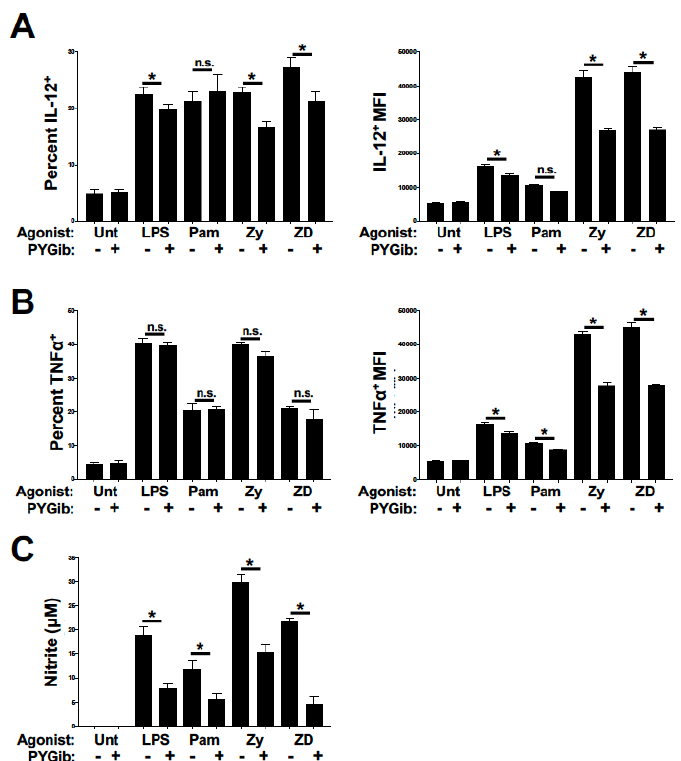
Figure 3. Glycogen phosphorylase inhibition causes deficits in inflammatory cytokine expression and nitric oxide production in response to TLR and Syk-dependent CLR agonists: ( A and B ) DCs were stimulated for 6 h with the indicated ligands and GolgiPlug reagent (LPS = lipopolysaccharide, Pam = Pam2CSK4, Zy = Zymosan, and ZD = Zymosan depleted) in the presence or absence of PYG inhibitor (PYGib), and then assessed by flow cytometry for intracellular expression of IL-12p70 ( A ) and TNF α ( B ). The percent of cytokine-positive cells (from total CD11c + cells) is depicted in the left panels, while the mean fluorescence intensities of cytokine-positive cells are depicted in the right panels. ( B ) Percent of CD40 and CD86 double-positive cells for each condition as depicted in ( A ). ( C ) DCs were stimulated for 18 h with the indicated conditions as above, and supernatants were then collected and analyzed for nitrite accumulation by Griess assay. For all graphs, statistical values are represented with an asterisk (*) as significant when p values are equal to or below 0.05, with mean +/ − SD shown, n = 4.